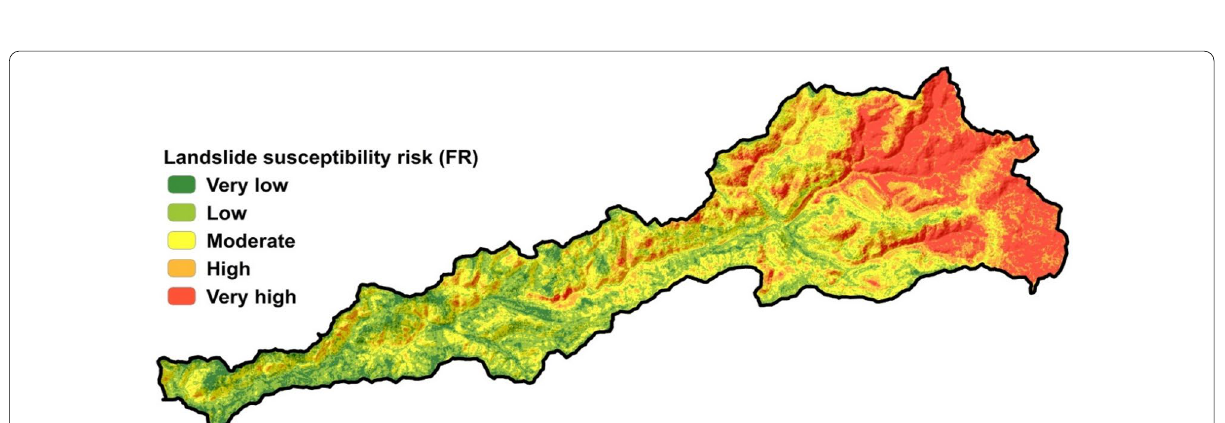
Fig. 4 Landslide susceptibility map in FRB obtained from the FR